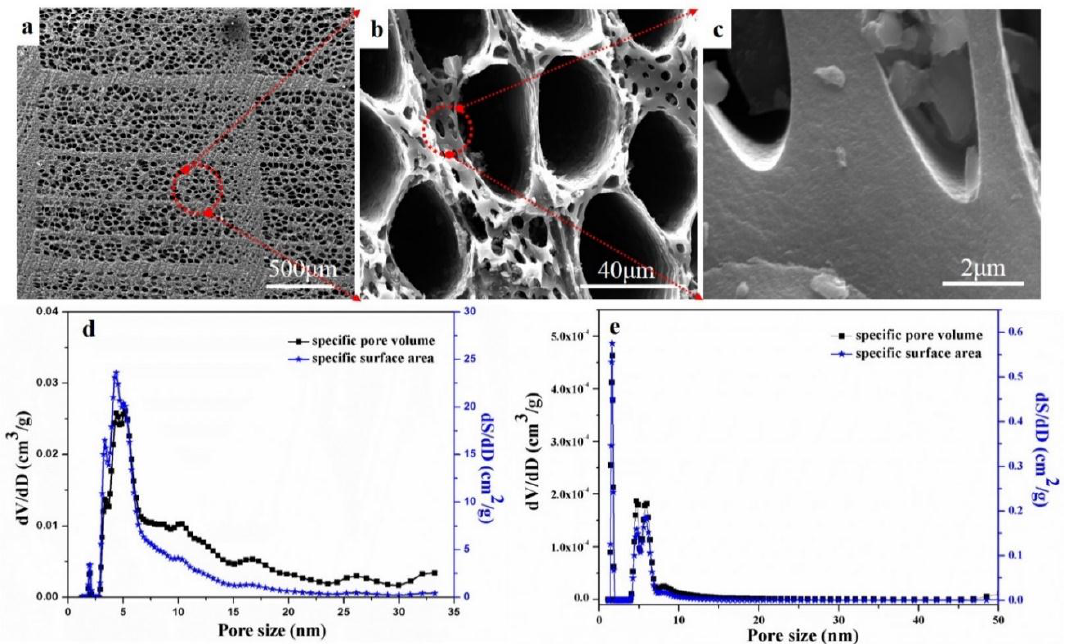
Figure 1. ( a – c ) SEM micrographs and ( d , e ) pore size distributions (based on BET analysis ) of